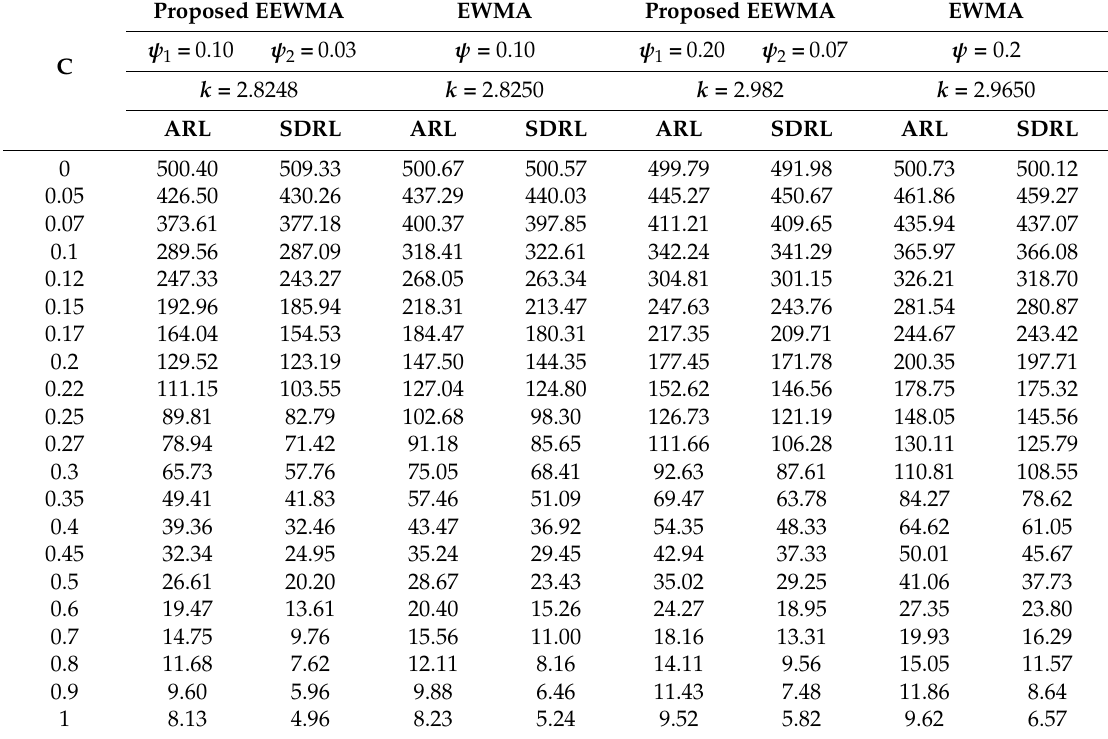
Table 1. The average run length (ARL), standard deviation of run length (SDRL) values of the proposed extended exponentially weighted moving average (EEWMA) and exponentially weighted moving average (EWMA) control charts for various shifts when r 0 =